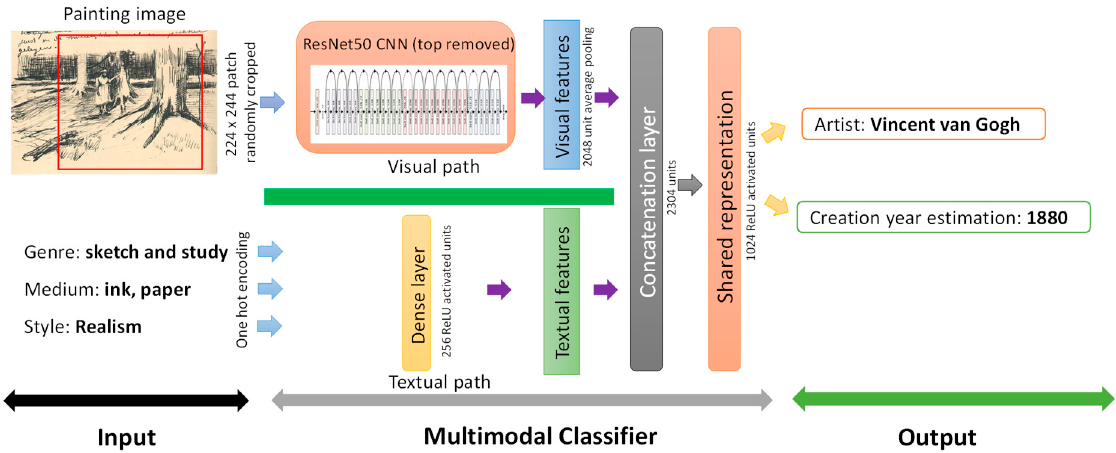
Figure 9. Model architecture. Figure 9 . Model architecture.